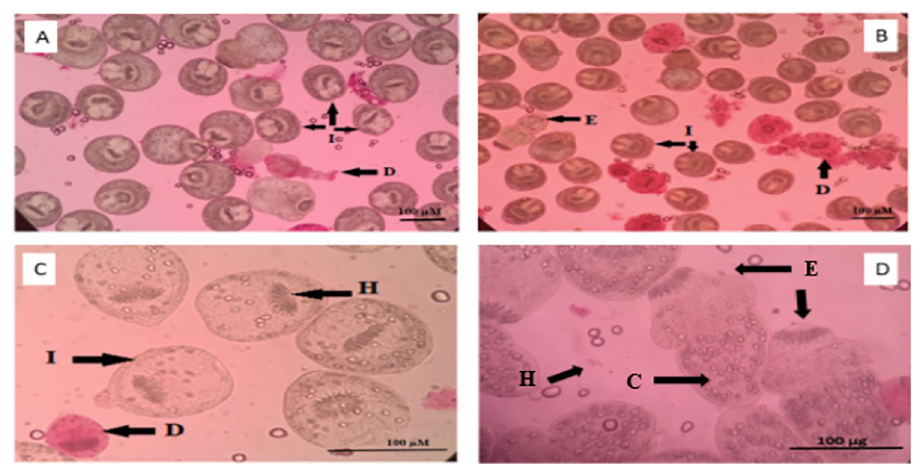
Fig 4. Assessment of PC viability by the eosin exclusion test. Light microscopy (LM) images showing viable evaginated (E) PCs, invaginated (I) unstained PCs, and red dead (D) PCs after 5 min staining with 0.1% eosin stain. H, hooks; C, calcareous corpuscles. (A and B) × 100, (C) × 200, and (D) × 400.